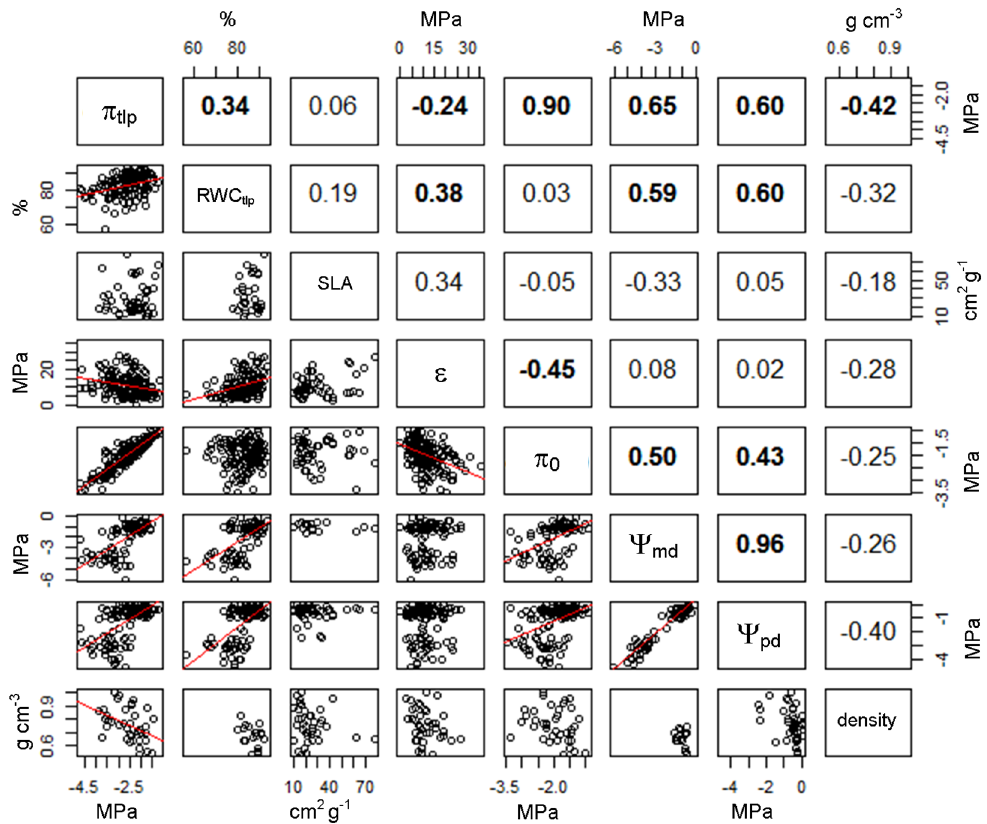
Figure 5. Correlation matrix of all plant traits included in the database. Scatter plots in lower, left quadrant are fitted with a linear function for significant correlations ( p < 0.01). Values in the upper right quadrant are Pearson’s correlation coefficients with bold text denoting significant correlation ( p <